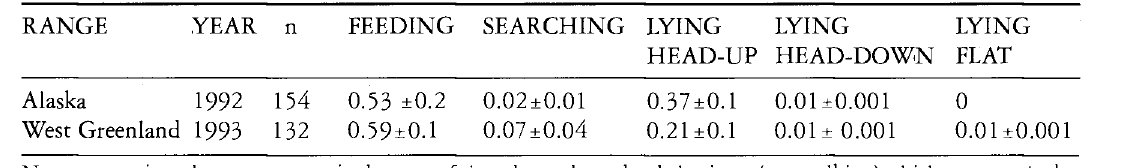
Table 1. Activity budgets of caribou of the Southern Alaska Peninsula, Alaska, USA, and Kangerlussuaq-Sisimiut, West Greenland, herds based on scans of groups during the calving seasons in 1992 and 1993 respectively. The proportion of time devoted to each activity is given as the mean proportions (± 1 SD) of the total number of caribou engaged in each activity in each scan averaged over the total number (») of scans.